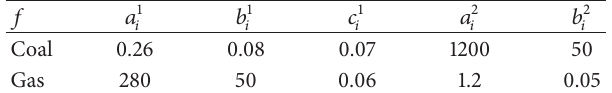
Table 7: Correlative coefficients of power generation